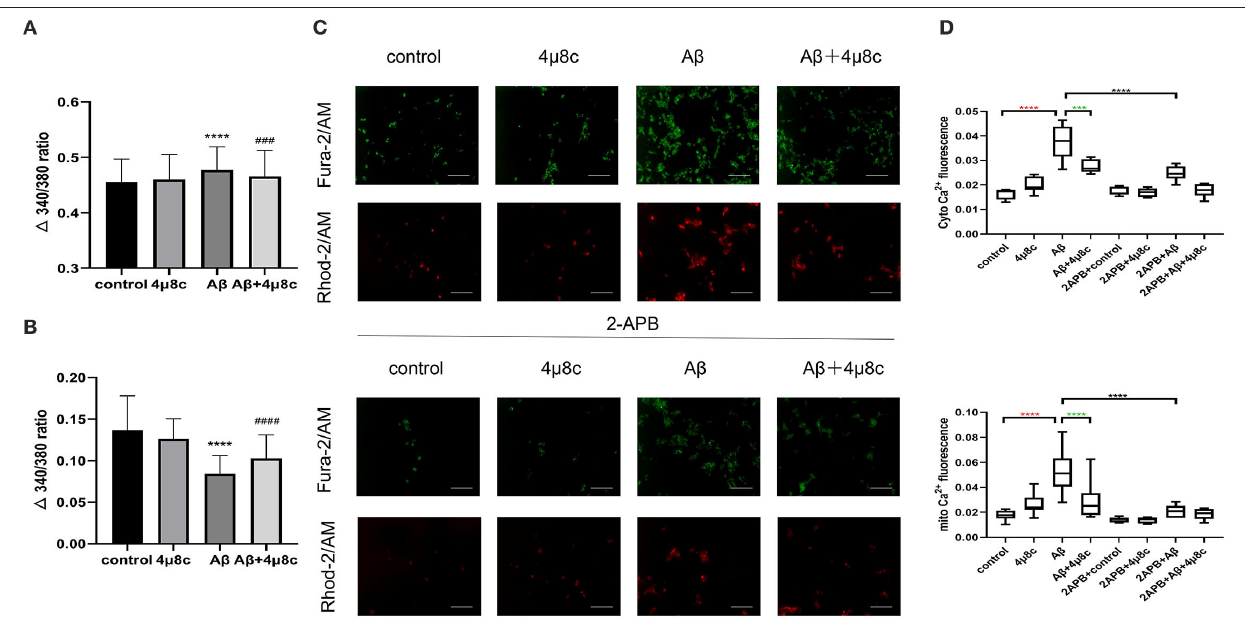
FIGURE 5 | The effect of IRE1 α -XBP1 on calcium transfer between the ER and mitochondria in A β -treated cells. Cells were pretreated with or without 20 µ M 4 µ 8c for 6h, followed by treatment with 20 µ M A β 25–35 for 24h. (A) Basal calcium levels in cells were measured using Fura-2 ratios. (B) Quantification of Tg-induced Ca 2 + release (reflecting ER Ca 2 + content). **** p < 0.0001 compared with the control group. ### P < 0.001 compared with the A β 25-35-alone group. #### P < 0.0001 compared with the A β 25–35-alone group. (C) Cytoplasmic and mitochondrial Ca 2 + content in cells measured by Fura-2/AM and Rhod-2/AM, respectively. Scale bar = 50 µ m. (D) The quantification of cytoplasmic calcium and mitochondrial calcium fluorescence intensity. Red * indicates the comparison of the control group with the A β 25–35 alone group. Green * indicates the comparison of the A β 25–35 alone group with the A β + 4 µ 8c group. Black * indicates the comparison of the A β 25–35 alone group with the 2APB + A β 25–35 group. The data are presented as mean ± SD ( n =